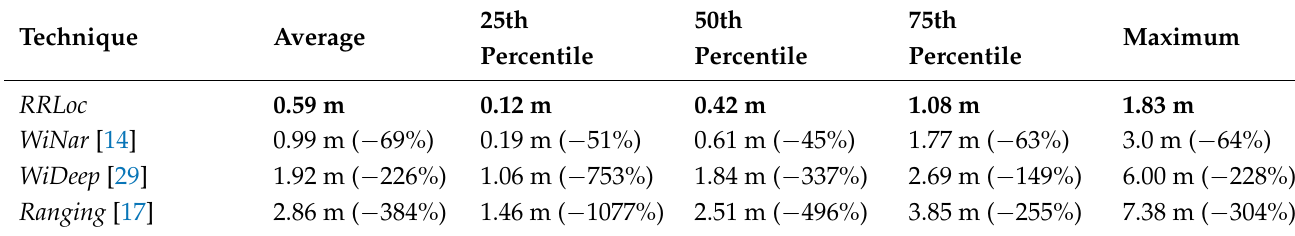
Table 5. The localization error percentilesin the Lab testbed.